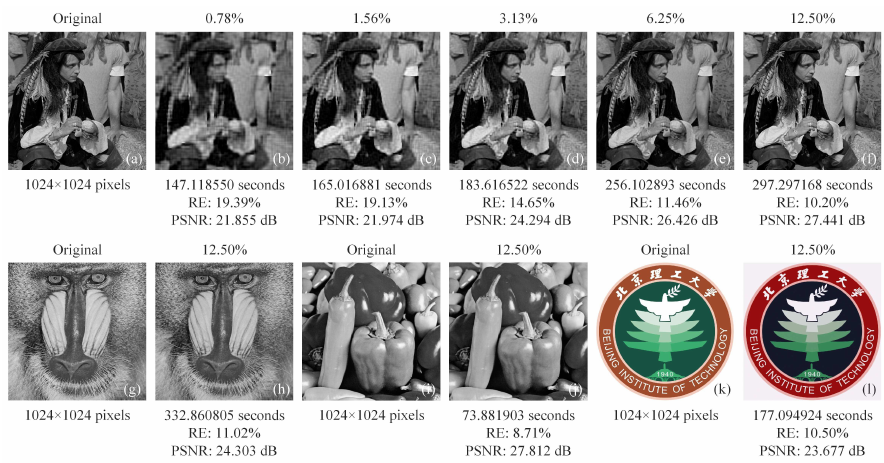
Figure 7. Reconstructions of different 2D images, covering gray-scale and color-scale, all of 1024 × 1024 pixels: ( a ) an original man image; ( b – f ) retrieved images with a 2 × stepping increase of the sampling ratio; ( g ) an original mandrill image; ( h ) recovered image of the mandrill with a sampling ratio of 12.50%; ( i ) an original image of peppers; ( j ) the reconstructed image of peppers using 12.50% measurements; ( k